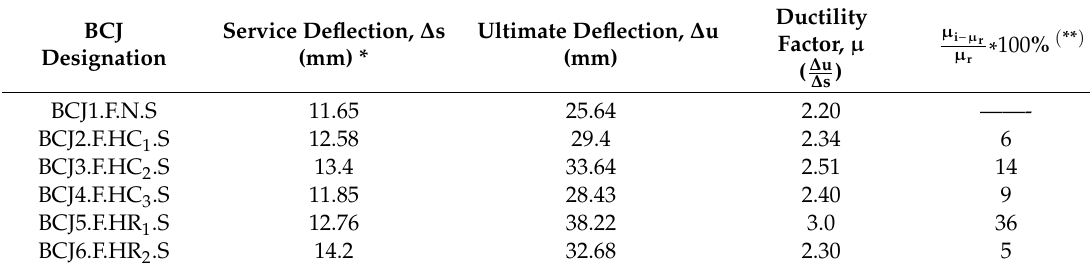
Table 5. Ductility ratio of tested BCJs under static